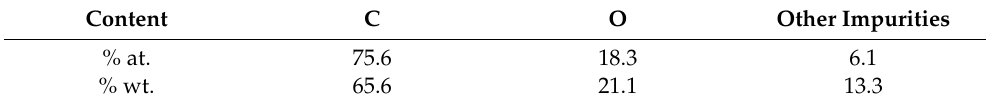
Table 2. Elemental chemical composition of the ACPK